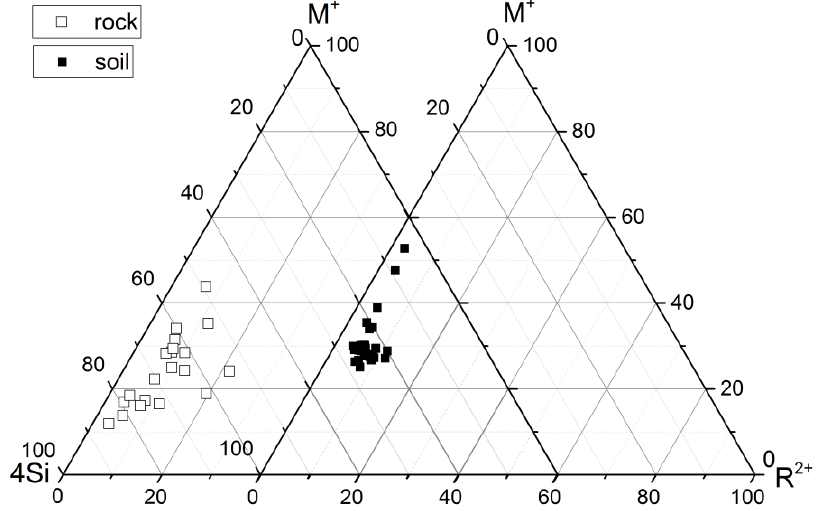
Figure 7. A M + -4Si-R 2+ diagram for rock and soil from the Mănăila area.